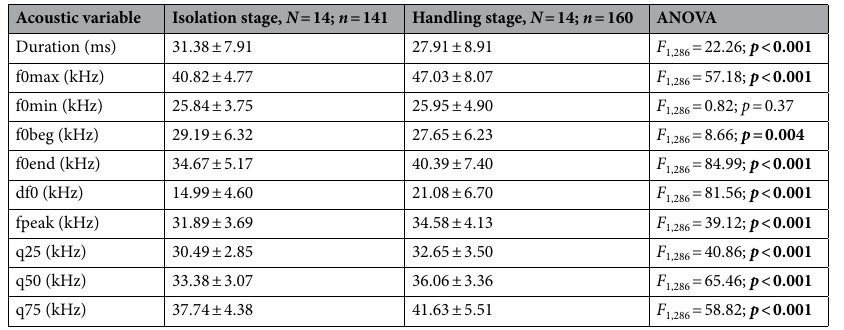
Table 5. Values (mean ± SD ) of the acoustic variables of single USVs with frequency jump and two-way ANOVA results for comparison between isolation and handling experimental stages. Animal individual identity was introduced in model as random factor. Designations as in Table